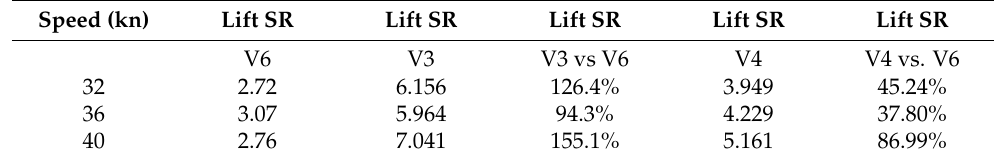
Table 11. Comparison of lift computed on SR.